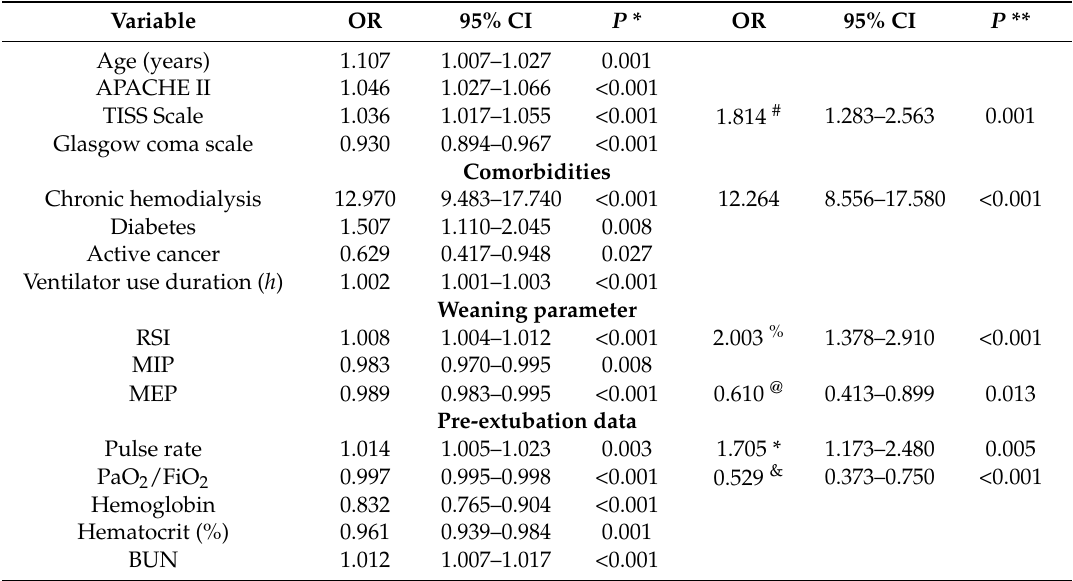
Table 2. Significant predictors of the failed extubation of all planned extubation patients.